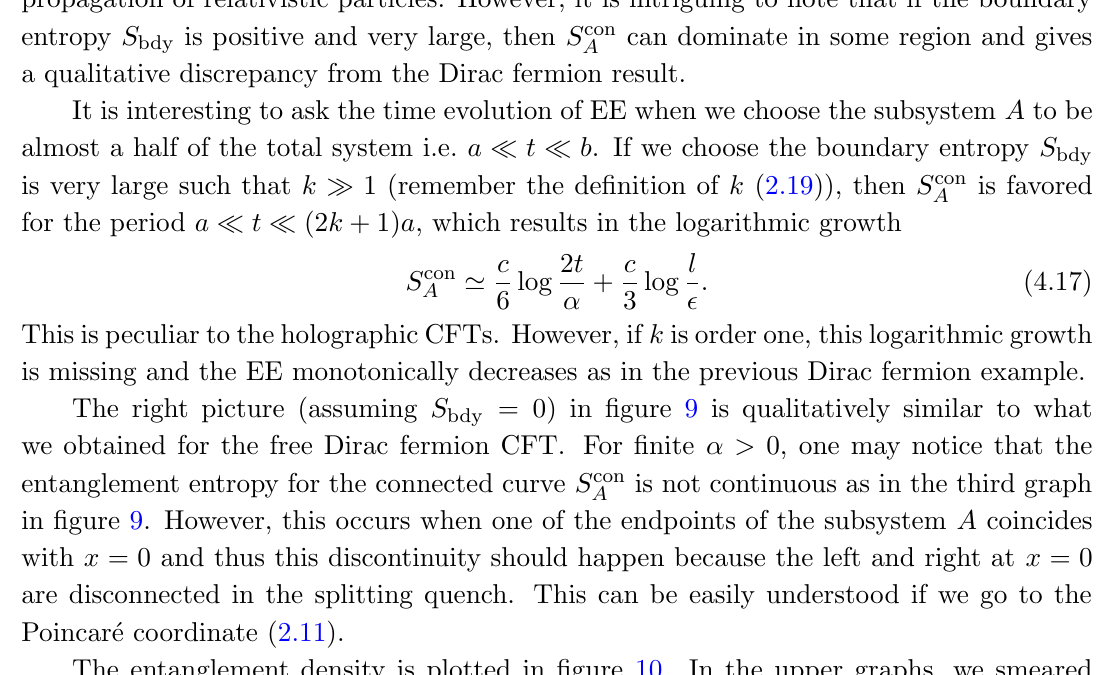
Figure 9 . The plots of the holographic entanglement entropy growth S A (cid:0) S (0) assume the tension of the boundary surface Q is vanishing T BCFT = 0. The blue/red graph describes the connected/disconnected contribution. The left graph describes the time evolution when we take ( a; b ) = (15 ; 20). The middle one is the time evolution for ( a; b ) = (0 : 1 ; 20). The right one is the plot for various (cid:24) when we (cid:12)x l = 2 and t =